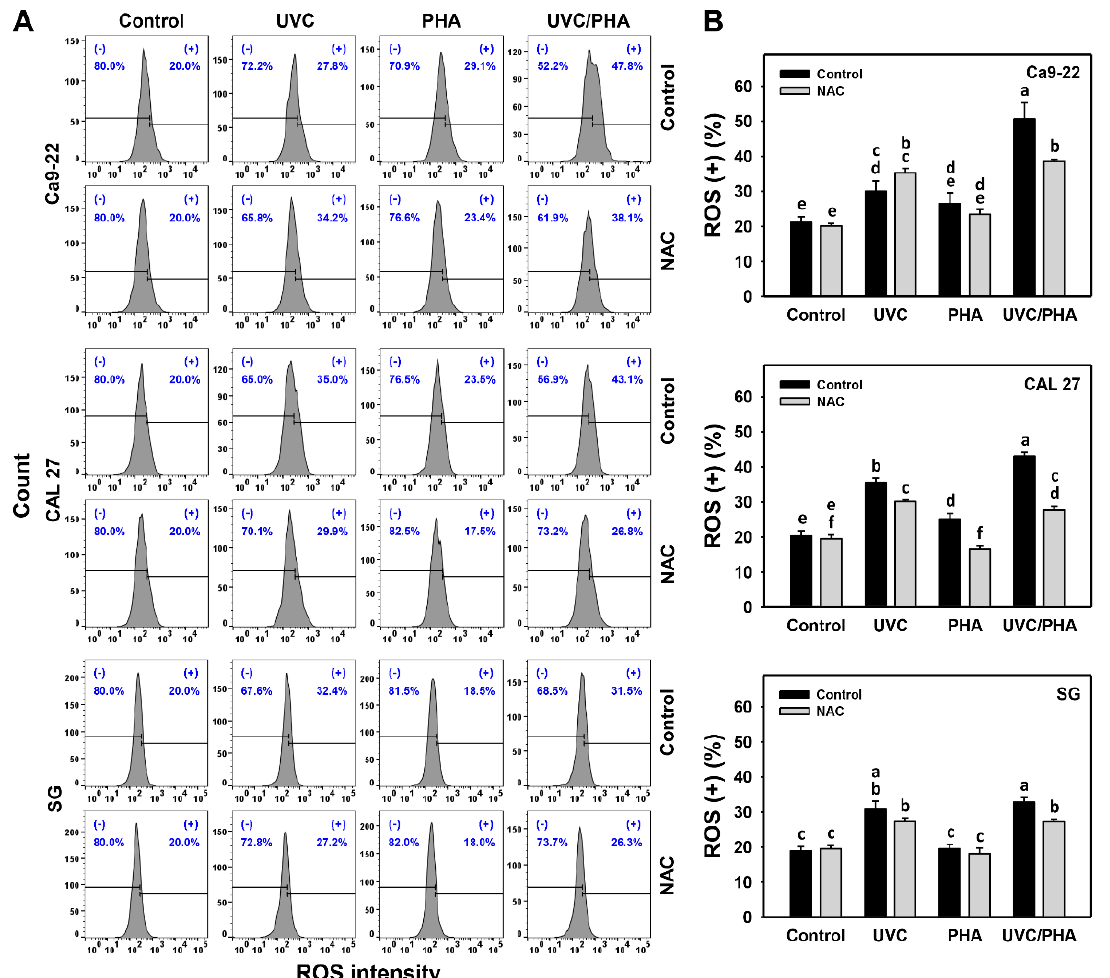
Figure 5. UVC/PHA-induced ROS in oral cancer cells. In the presence or absence of NAC, oral cancer and normal (SG) cells were grouped into four treatments, i.e., control, UVC, PHA, and UVC/PHA, for 24 h. The doses for the UVC and PHA treatments were 8 J/m 2 and 0.8 µ M, respectively. ( A , B ) Profile and data. (+) (%) indicates ROS-positive (%). For comparison, treatments labeled with different letters (a to f) produced significantly different results ( p < 0.05). Data are presented as mean ± SD ( n = 3 independent experiments, with each experiment involving 5000 gated cell